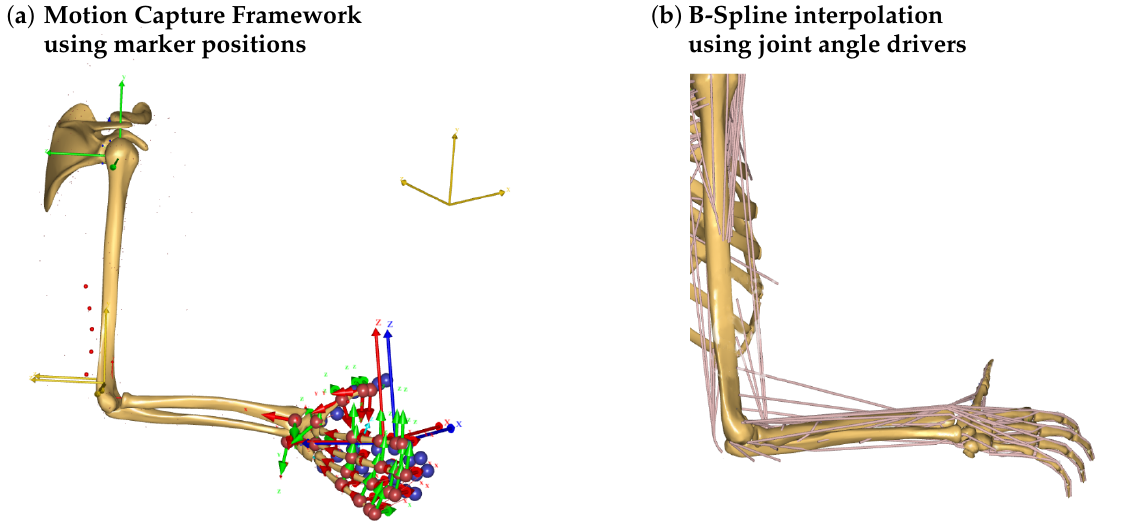
Figure 1. Possibilities to process recorded motion in the AMS. ( a ) MoCap simulation uses motion files with trajectories of marker coordinates. The distances between the recorded coordinates of the blue points from the movement file and the red reference points on the skeleton are minimized by solving an optimization problem. The arrows represent the orientation of the local and global coordinate systems. ( b ) Joint angle interpolation is based on B-spline interpolation of recorded motion and uses the resulting continuous function for driving the joint according to flexion/extension, abduction/adduction, and pronation/supination.